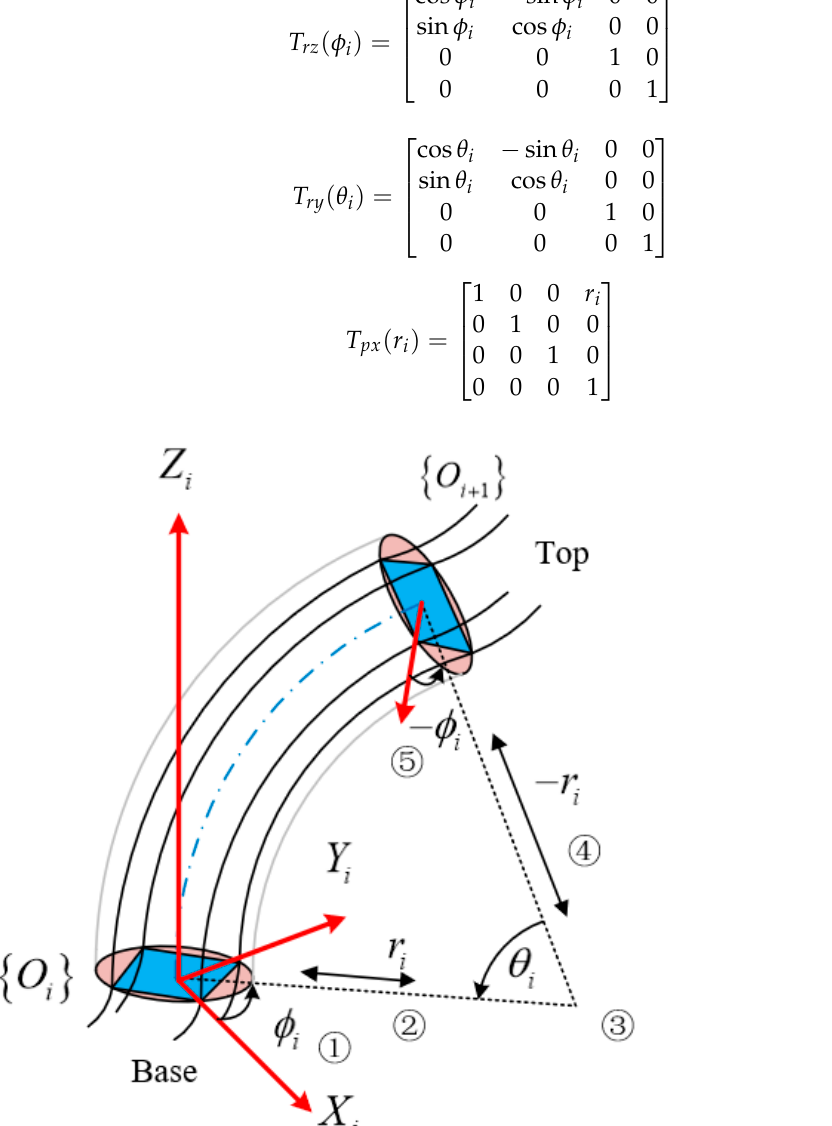
Figure 4. Diagram of single continuum node CPHTM based on enhanced D ‐ H method.